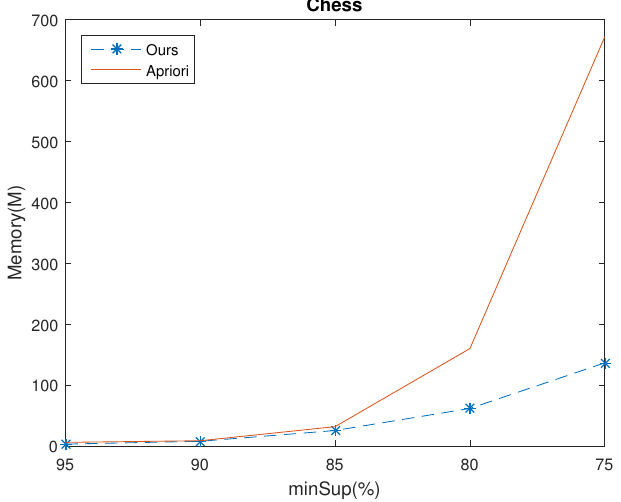
Figure 8. Memory usage of the two algorithms in Chess dataset for various minSup values.